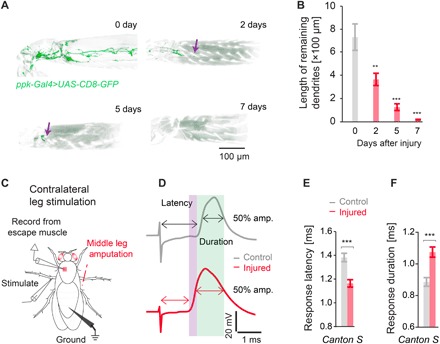
Peripheral injury leads to sensory neuropathy, central sensitization, and augmentation of the nociceptive escape circuit.(A) ppk+ sensory neuropathy is observed after leg amputation. (B) Quantification of sensory neuropathy (ppk1+ projection length) in the amputated leg over time (n ≥ 7). (C) Adult nociception electrophysiology preparation after injury. (D to F) Leg amputation results in contralateral sensitization of the escape response circuit with (D and E) increase in escape circuit velocity (velocity difference highlighted in purple) and (D and F) an increase in the duration of the escape response (injured duration highlighted in green) (n ≥ 9). Data are represented as means ± SEM. **P < 0.01; ***P < 0.001, two-way ANOVA followed by Tukey’s post hoc test (B) and Mann-Whitney-Wilcoxon test (E and F).